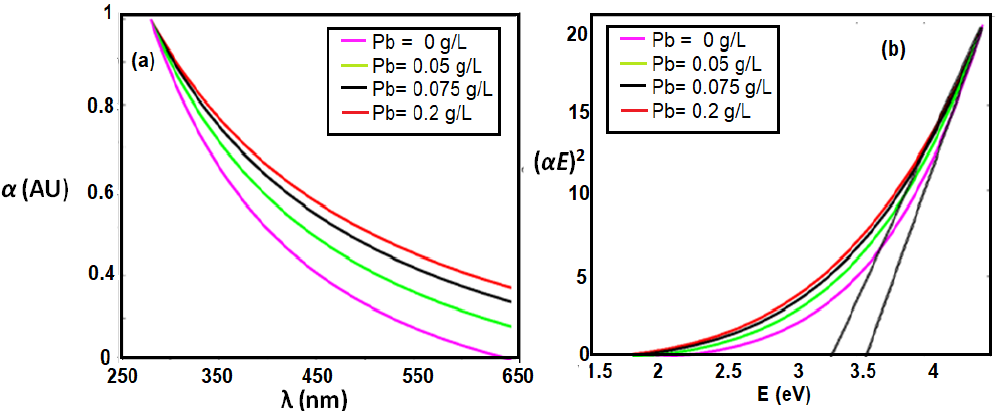
Figure 7. ( a ) Absorbance dispersion; and ( b ) bandgap calculations for gold-ceria nanoparticles at added Pb concentrations to prove the static mechanism of the sensing.